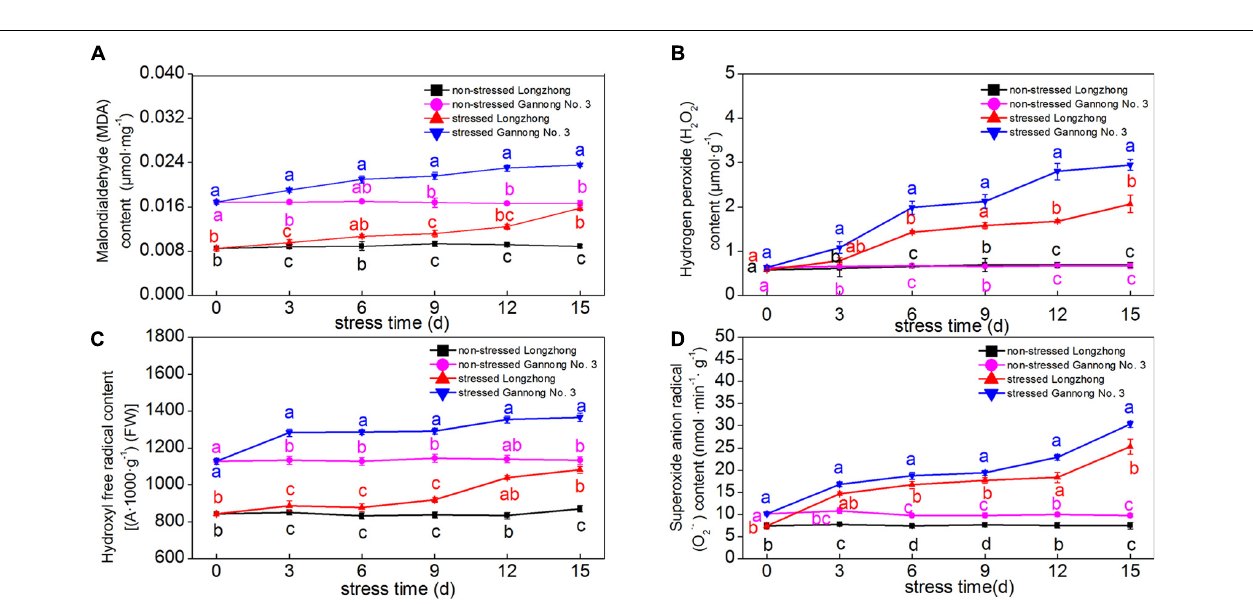
FIGURE 1 | Changes of root activity (A) and the contents of soluble protein, soluble sugar, and proline (B–D) in two alfalfa varieties under non-stressed and stressed conditions at different time points. Different letters above line graphs indicate significant difference among treatments at a given day of treatment ( P ≤ 0.05), and vertical bars indicate ± SE of mean ( n = 3).